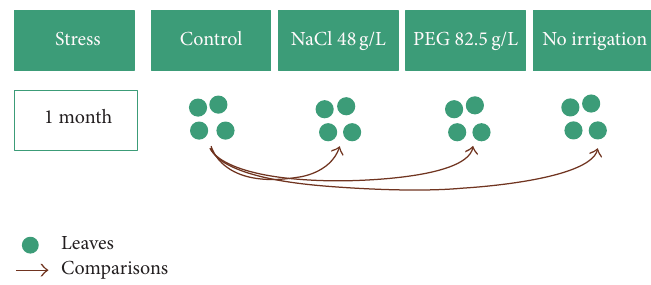
Figure 1: Scheme of the performed proteome analysis.